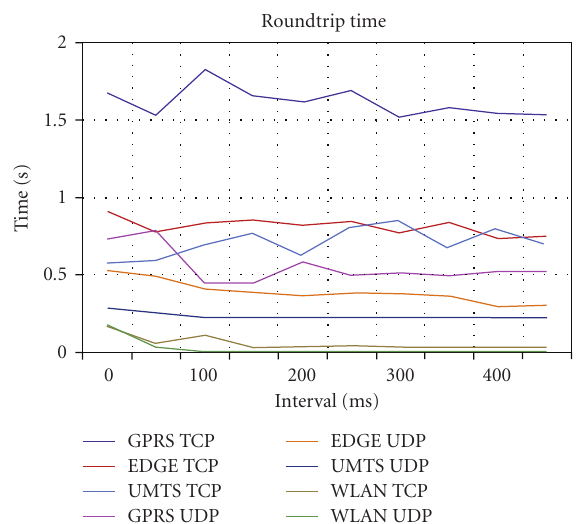
Figure 6: Measured response time including transmission